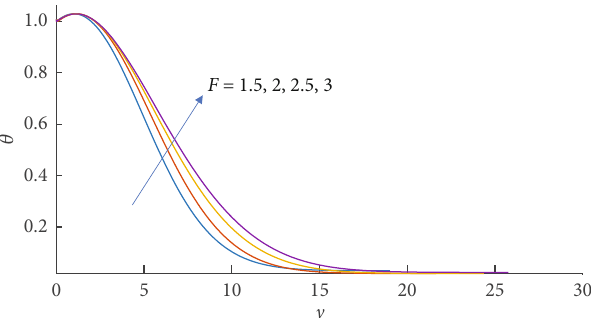
Figure 5: Increasing values of F for temperature fi eld when t = 0 : 2 , Pr = 6 : 2 , Ec = 0 : 1 , and H = 2